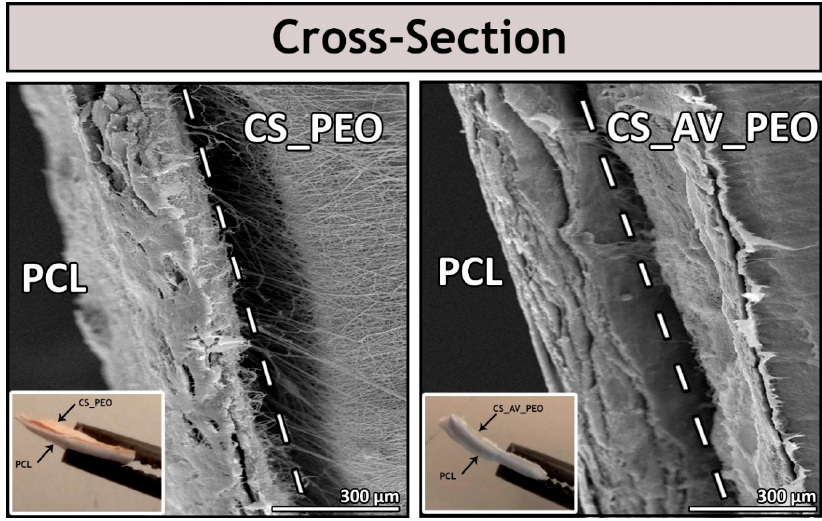
Figure 1. Scanning electron microscopy (SEM) and macroscopic images of the cross-section of the produced bilayer membranes (PCL/CS_PEO and PCL/CS_AV_PEO).